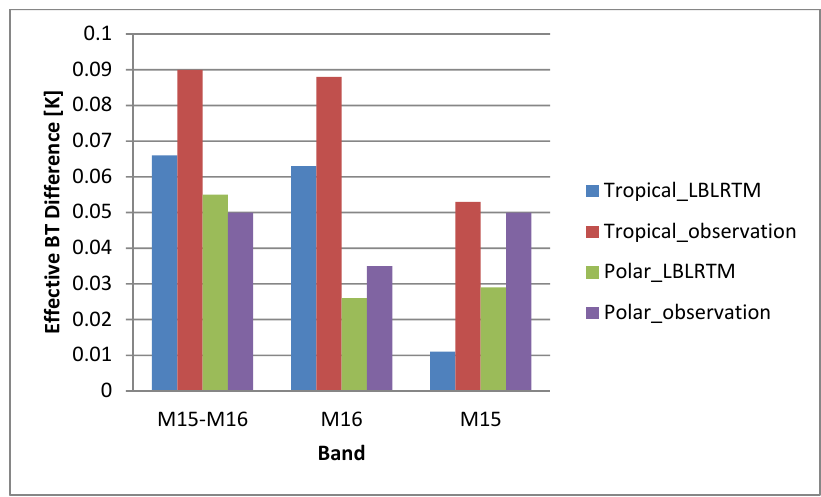
Figure 8. Comparison of effective temperature difference between LBLRTM and the VIIRS observation for tropical and polar cases. Note: VIIRS observation uses the average of several cases to represent the tropical and polar case.